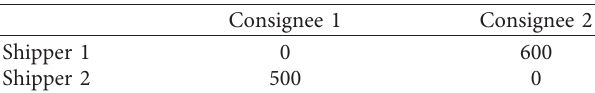
Table 4: Circulation of cargoes at supply and demand points in the small bulk cargo transport network (0 means there is no supply and demand